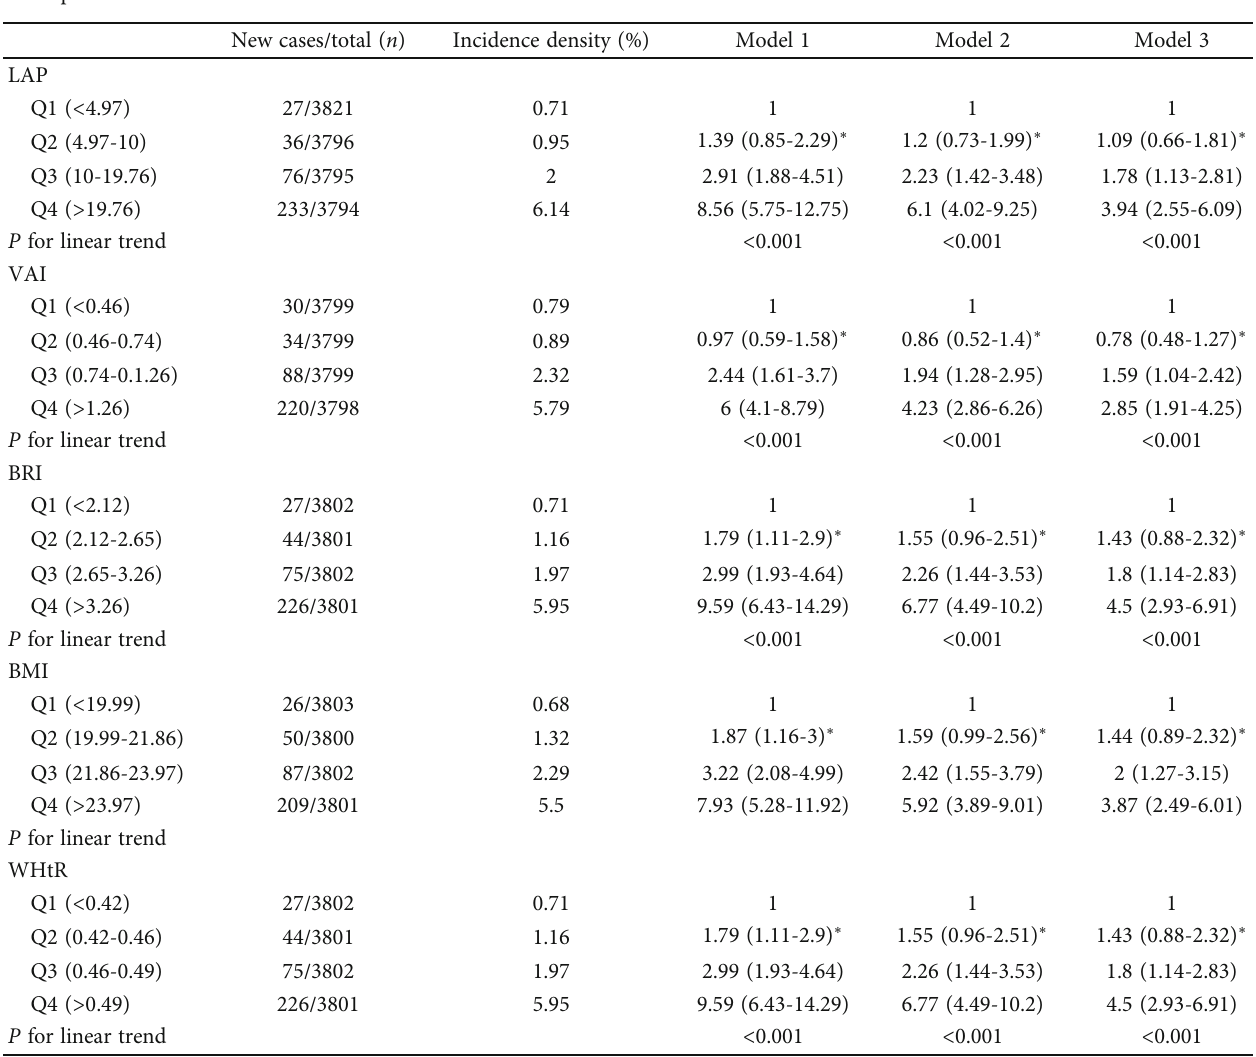
Table 3: Results of Cox proportional risk regression model analysis of the relationship between di ff erent obesity markers and the development of